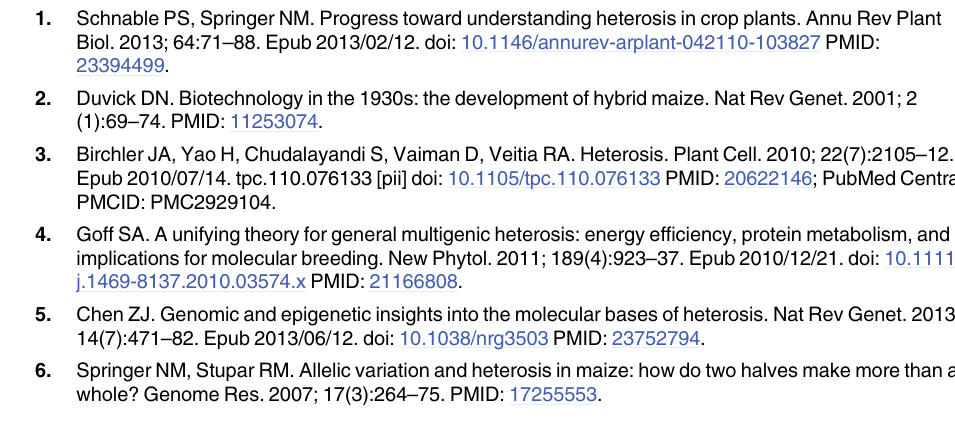
S1 Table. ChIP-seq mapping summary. S2 Table. Genomic loci and annotated genes associated with ZmCCA1-binding peaks. S3 Table. Enrichment of Gene Ontology (GO) groups of ZmCCA1-binding targets. S4 Table. List of primers used in qRT-PCR and ChIP-qPCR. S5 Table. List of oligonucleotides used in